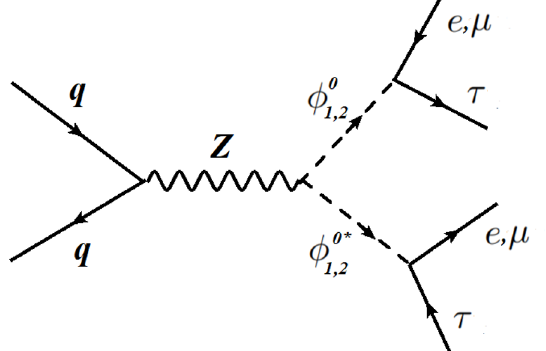
Figure 11 . Feynman diagram for the novel signature pp ! e (cid:0) e + (cid:28) (cid:0) (cid:28) + ; (cid:22) (cid:0) (cid:22) + (cid:28) (cid:0) (cid:28) + in the SU(2) H model at the LHC via exchange of the CP even and CP odd scalars.